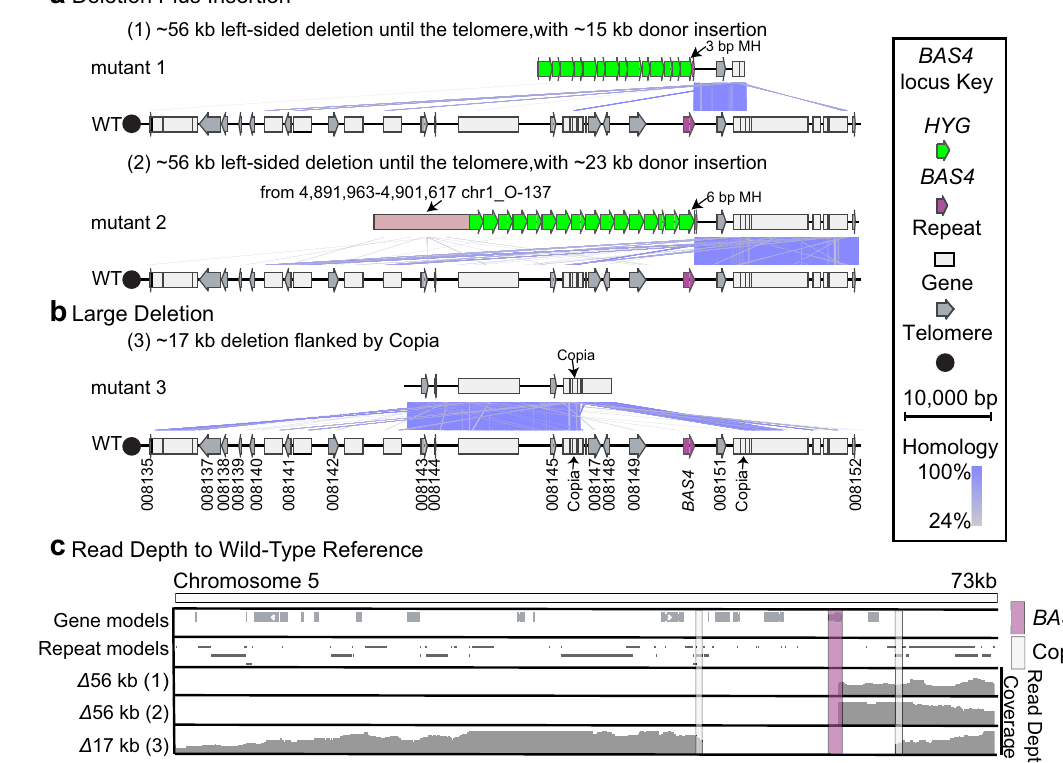
Fig. 5 | Large-scale DNA deletions at subtelomeric BAS4 locus. Microsynteny between assembled bas4 edited strains (top) and the wild-type (bottom) indicated by purple connecting bands ranging from 24to 100% similarity asindicated by the color scale. Three Δ bas4 mutants with two mutations classes ( a ) deletion plus insertion and ( b ) large deletion were sequenced and displayed. The pink labelled segment in (2) indicated sequence inserted from different chromosome. MH indicates the shared microhomology. c Coverage of nanopore long-read mapping from telomere to the BAS4 locus. Reads were mapped to the O-137 wild-type